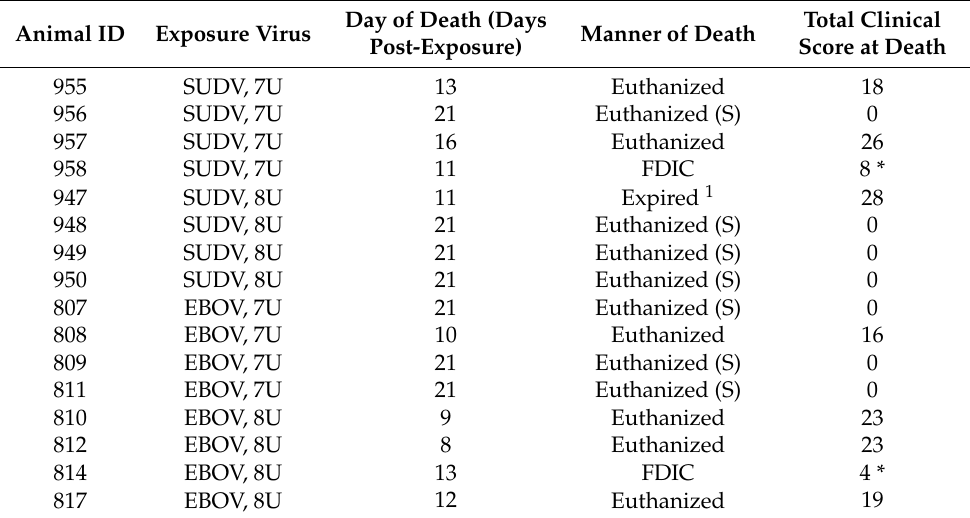
Table 2. Mortality